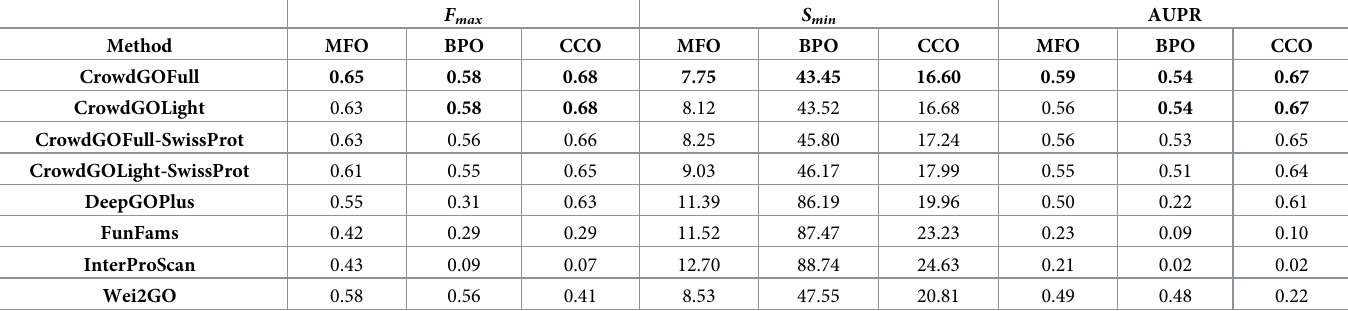
Table 2. Evaluations of GO term annotations from CrowdGO and four individual input predictors. Molecular Function (MFO), Biological Process (BPO), and Cellu- lar Component (CCO) ontologies; Highest F max scores and AUPR values, and lowest S min scores are in bold